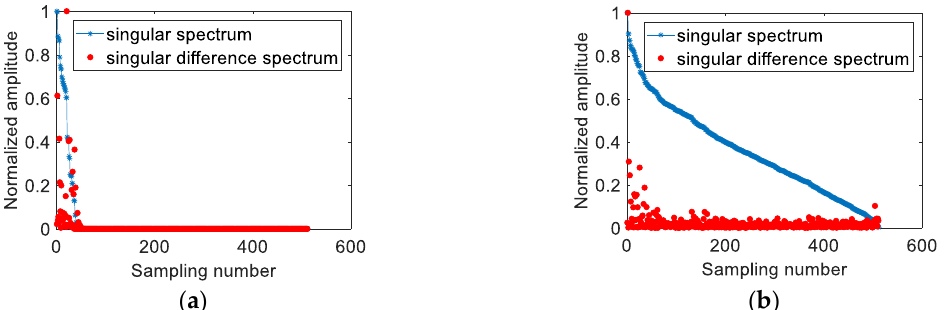
Figure 3. Singular spectrums and singular value difference spectrums, ( a ) the modulated signal without noise, ( b ) the white Gaussian noise.